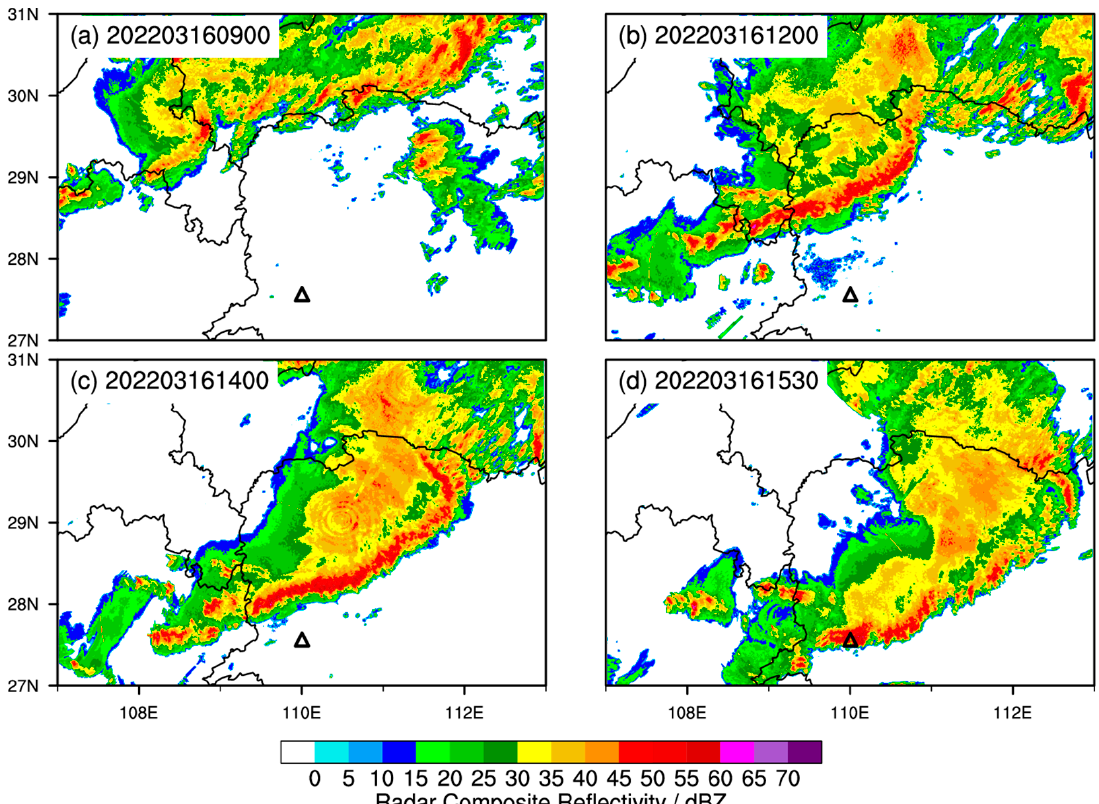
Figure 4. Radar mosaic showing radar reflectivity (dBZ) at ( a ) 0900 UTC, ( b ) 1200 UTC, ( c ) 1400 UTC, and ( d ) 1530 UTC on 16 March 2022. The triangle denotes the location of the S-POL radar.